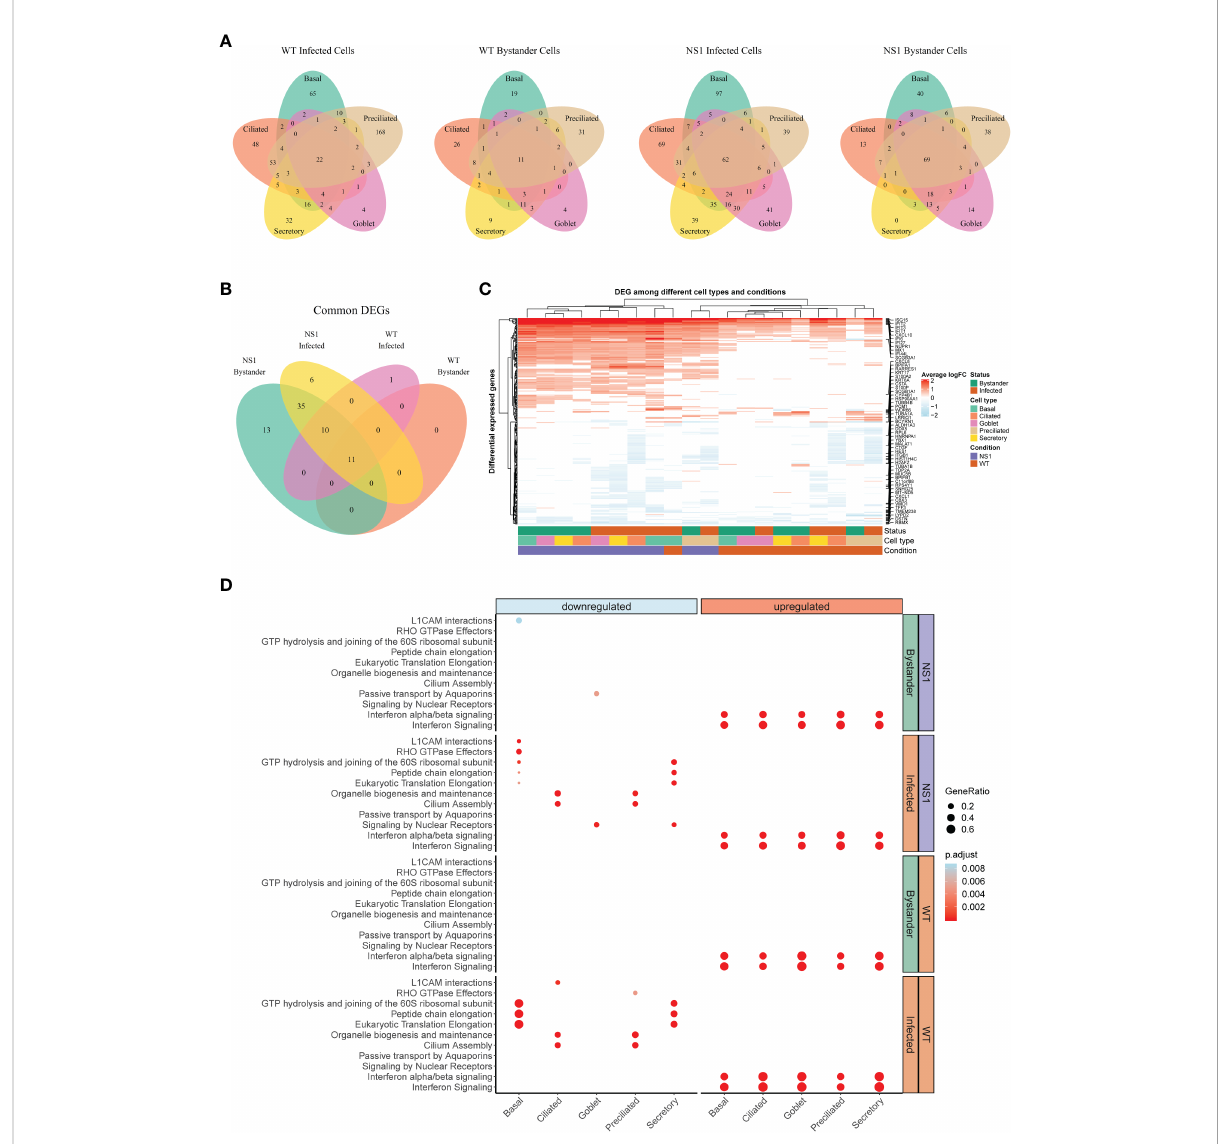
FIGURE 5 Global host antiviral response in WT and NS1 R38A virus-infected hAEC cultures. (A) Venn diagrams showing the overlap of differentially expressed genes (DEG) among different cell types for each of the following: 1) WT infected cells, 2) WT bystander cells, 3) NS1 R38A infected cells, and 4) NS1 R38A bystander cells. For each comparison, DEGs identi fi ed in every cell type ( “ common ” DEGs) are displayed in the center of the Venn diagram. (B) Venn diagram comparing the “ common ” DEGs identi fi ed in each of the comparisons above. A total of 11 core DEGs were present in all IAV-infected cells, regardless of the infection status (infected or bystander), cell type (ciliated, secretory, basal, goblet, or preciliated), or virus used for infection (WT or NS1 R38A virus). (C) Hierarchical cluster analysis of DEGs identi fi ed in WT and NS1 R38A conditions among different cell types in both infected and bystander populations. For each of the 20 distinct DEG pro fi les identi fi ed, the top 5 upregulated (red) and downregulated (blue) DEGs are annotated in the heatmap. (D) Dot plot illustrating pathway enrichment analysis performed on the 20 distinct DEG pro fi les. Enriched pathways are displayed on the left (y-axis) and the direction of enrichment is indicated at the top of the graph (downregulated in blue on the left panel; upregulated in red on the right panel). Signi fi cantly enriched pathways for WT (bottom 2 panels) and NS1 R38A (top 2 panels) are shown for infected (orange) and bystander (green) populations from each cell type (x-axis). Dots were adjusted in size and color to illustrate the gene ratio and adjusted p-value for a particular pathway,